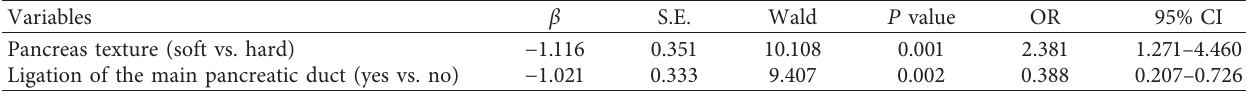
Table 5: Multivariate logistic regression analysis for postoperative pancreatic fistula after distal pancreatectomy (DP).